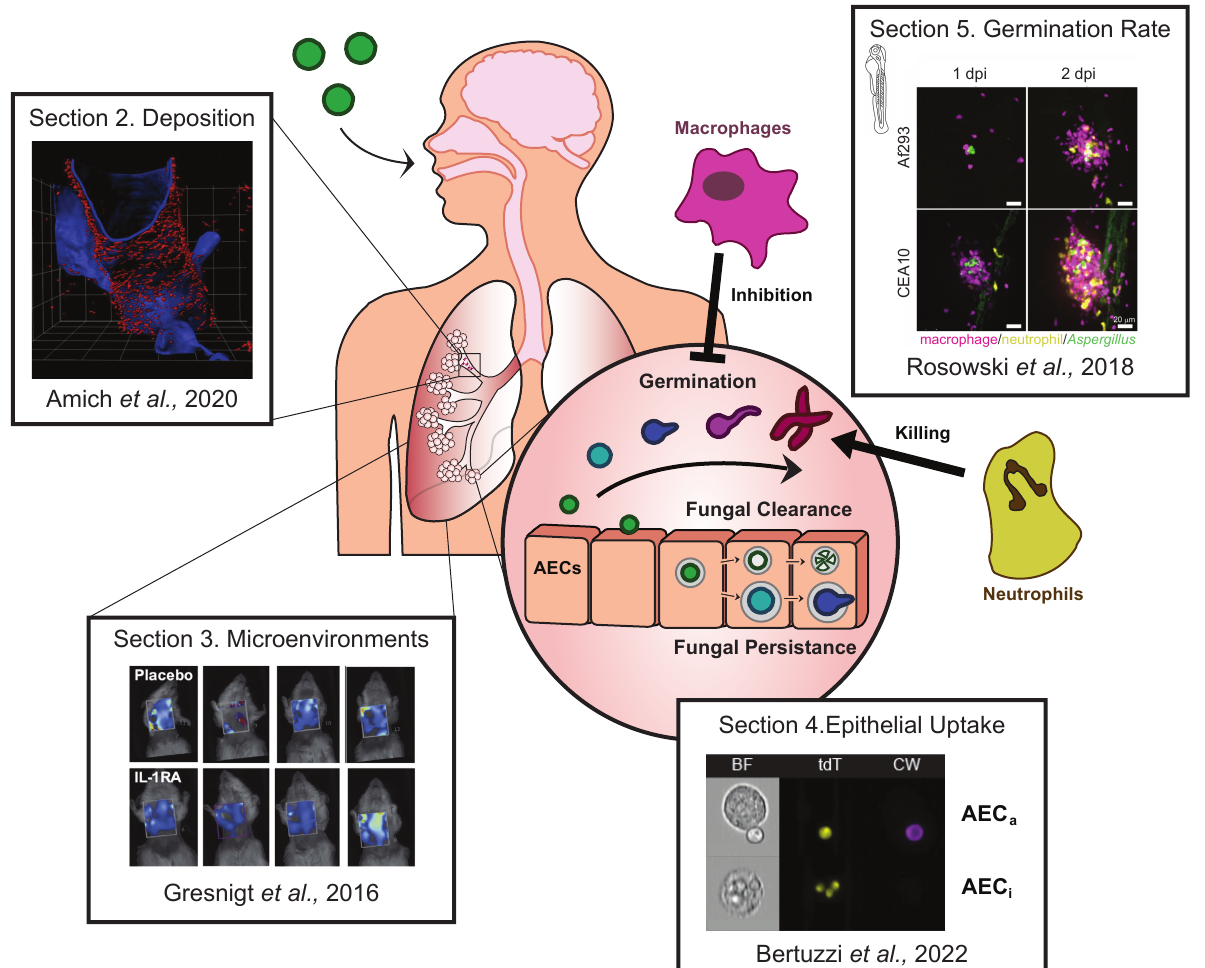
Figure 1. Diagram of new insights into A. fumigatus host–pathogen interactions attained through novel in vivo imaging techniques. Section 2 : Work by Amich et al. (2020) used light sheet fluorescence microscopy (LSFM) to look at A. fumigatus lung deposition [15]. Section 3: Gresnigt et al. (2016) investigated the interplay between hypoxic lung environments and inflammation during A. fumigatus infection using fluorescence tomography [16]. Section 4: Bertuzzi et al. (2022) leveraged imaging flow cytometry (IFC) to demonstrate in vivo uptake and killing of A. fumigatus by airway epithelial cells (AECs) (BF: bright field, tdT: tdTomato identifying interacting A. fumigatus , CW: calcofluor white identifying external A. fumigatus ) [17]. Section 5: Rosowski et al. (2018) used a zebrafish model of aspergillosis to demonstrate that germination rate can alter neu-trophil recruitment and antifungal activity while also being modulated by macrophages